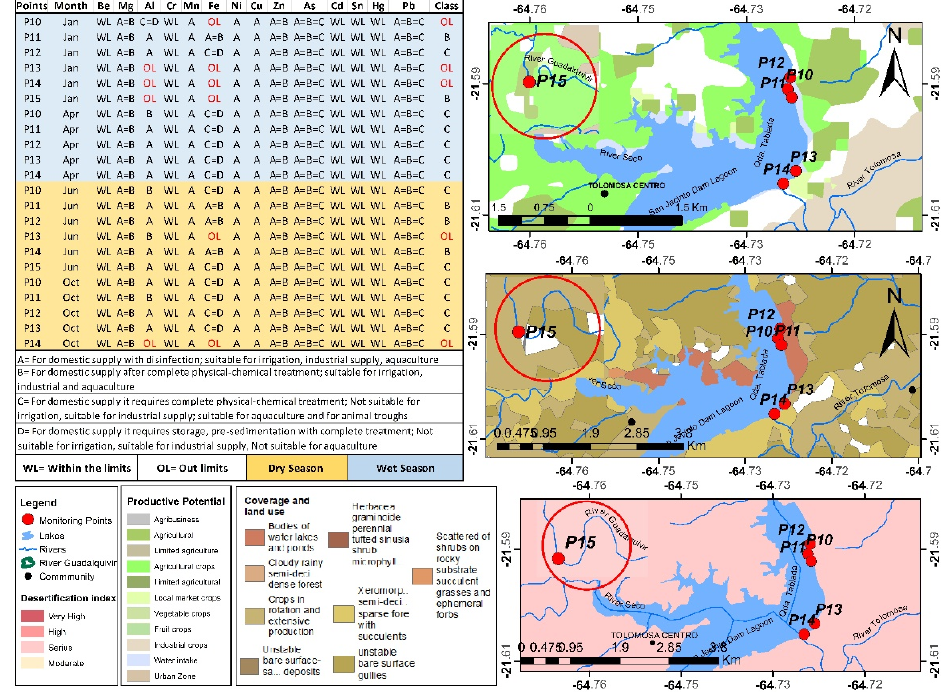
Figure 11. Water quality classification in the monitored points in the Central Guadalquivir area. P10 had water quality between Class B and D in the wet season due to Fe concentra- tions outside the permissible limits. In the dry season, P10 presented a Class C